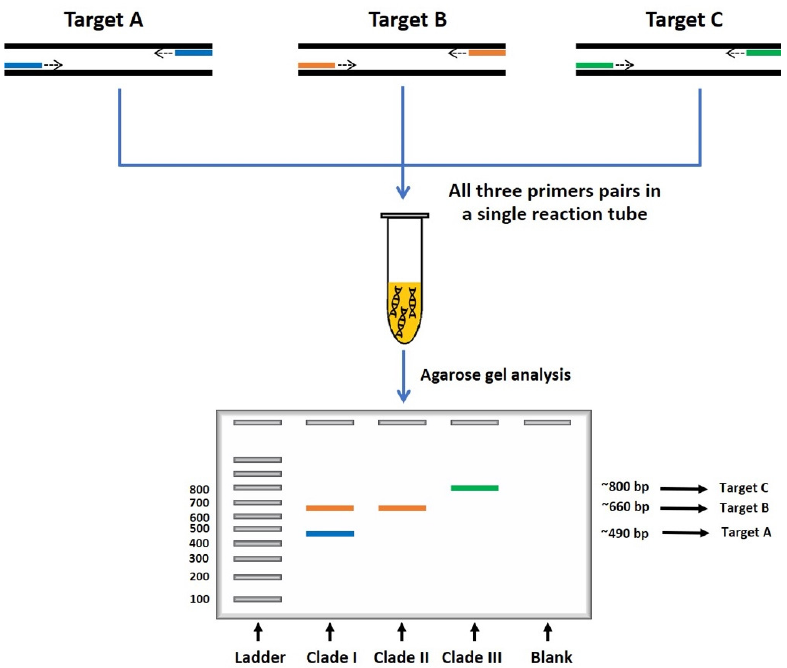
Figure 6. Schematic diagram of multiplex PCR assay for detecting and genotyping P. insidiosum . The multiplex PCR requires several pairs of primers (represented as short blue, orange, and green lines) to simultaneously amplify multiple target sequences (i.e., different rDNA sequence regions of P. insidiosum ) in one reaction tube. The number and sizes of the resulting amplicon can be assessed by gel electrophoresis, which aided in identifying and genotyping the organism in question. The diagram is adapted from the references [19,59].